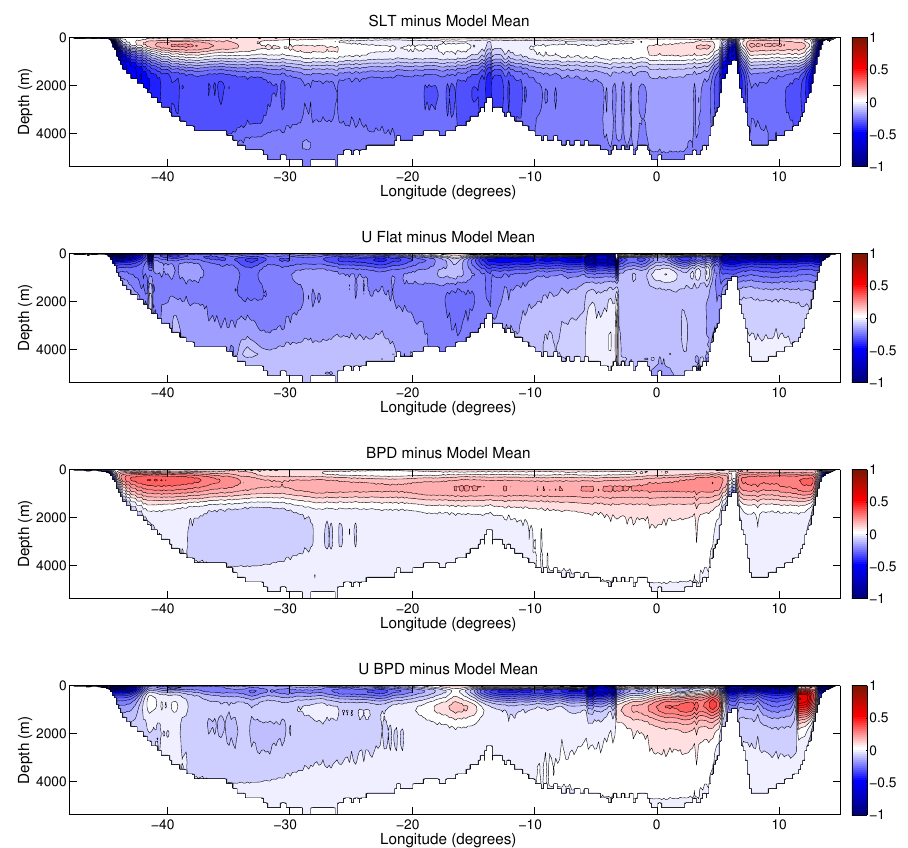
Fig. 9. Theoretical sections (Fig. 8) minus the mean model section (Fig. 5c). (a) Standard linear theory minus the mean model section, (b) mean flow with a flat bottom minus the mean model section, (c) no mean flow with topography minus the mean model section, and (d) mean flow and topography minus the mean model section. Contour interval is 0.05.